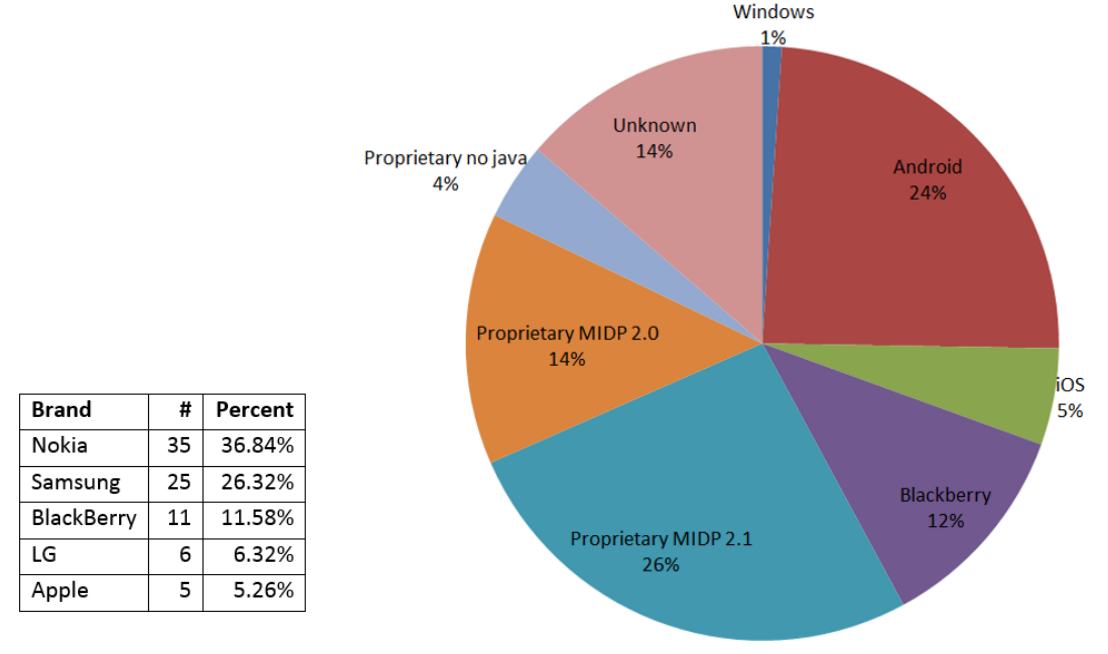
Figure 1: (a) Top five brands of mobile devices and (b) mobile operating